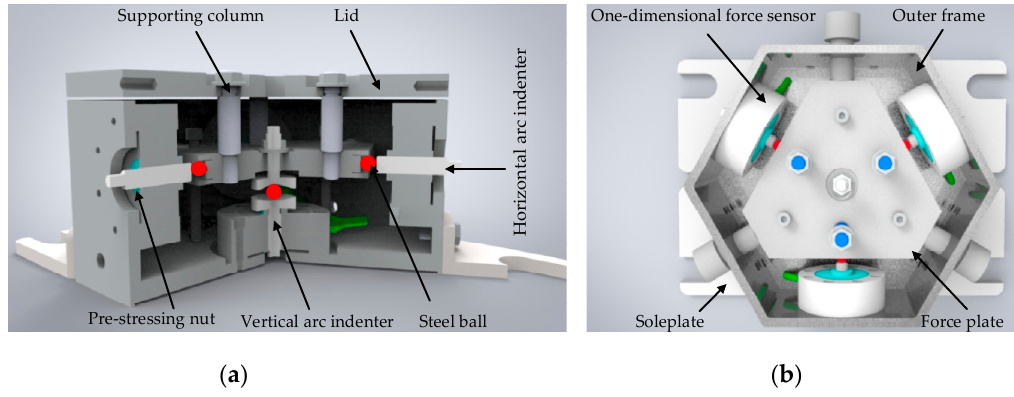
Figure 2. Internal structure of the parallel three-dimensional force sensor. ( a ) The internal structure of the sensor; ( b ) The top view of the internal structure.